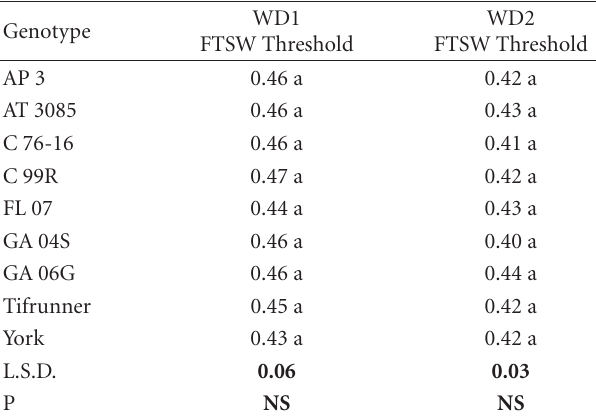
Table 4: Results from the two deficit experiments (WD1 and WD2) showing the FTSW-threshold for the decline in transpiration rate. Values followed with the same letter are not statistically di ff erent on LSD (Least Significant Di ff erence) values calculated using Tukeys method ( P < 0 . 05). The notation NS means